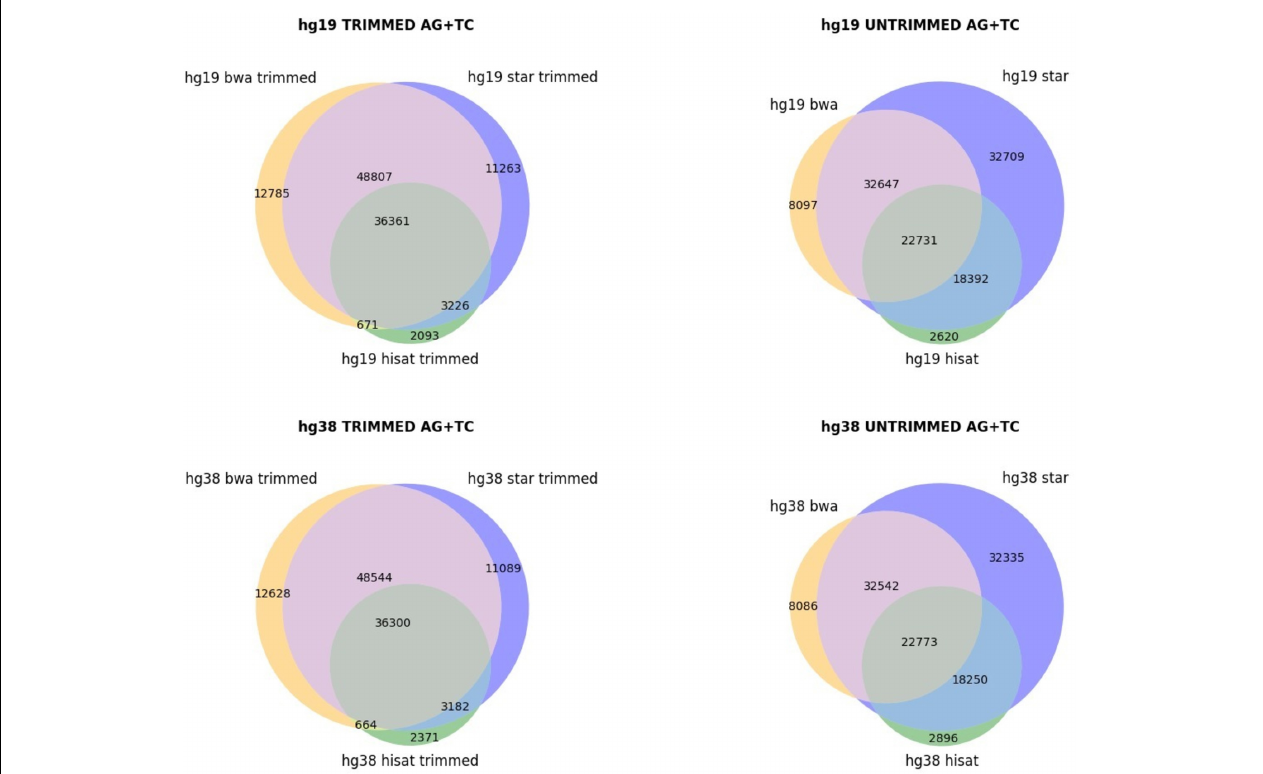
FIGURE 2 | Venn diagrams, showing the AG/TC overlapping positions for BWA, STAR, and HISAT2 aligners. The comparison is made for trimmed and untrimmed reads mapping onto hg19 and hg38 assemblies, respectively.